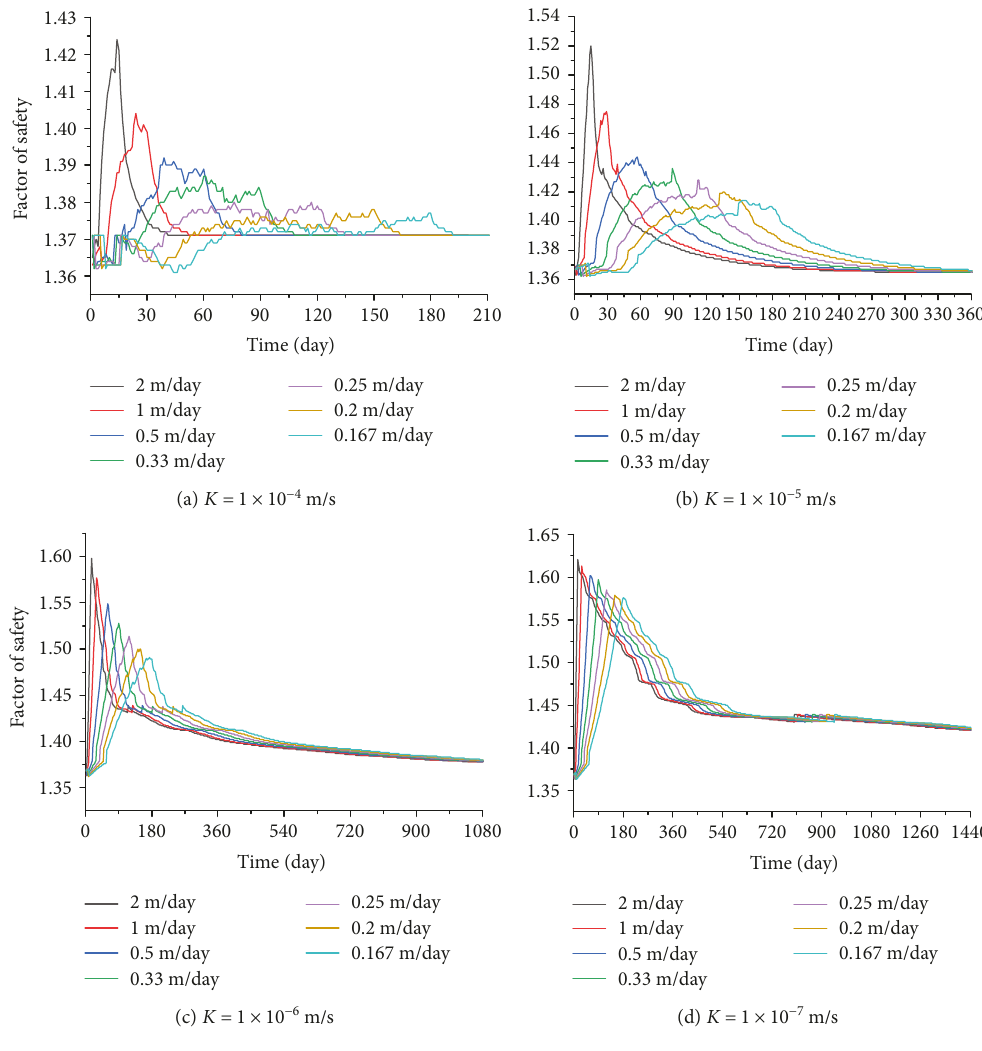
Figure 14: FOS variation under di ff erent conditions. (4) Calculation of the Grey Relational Degree . The grey